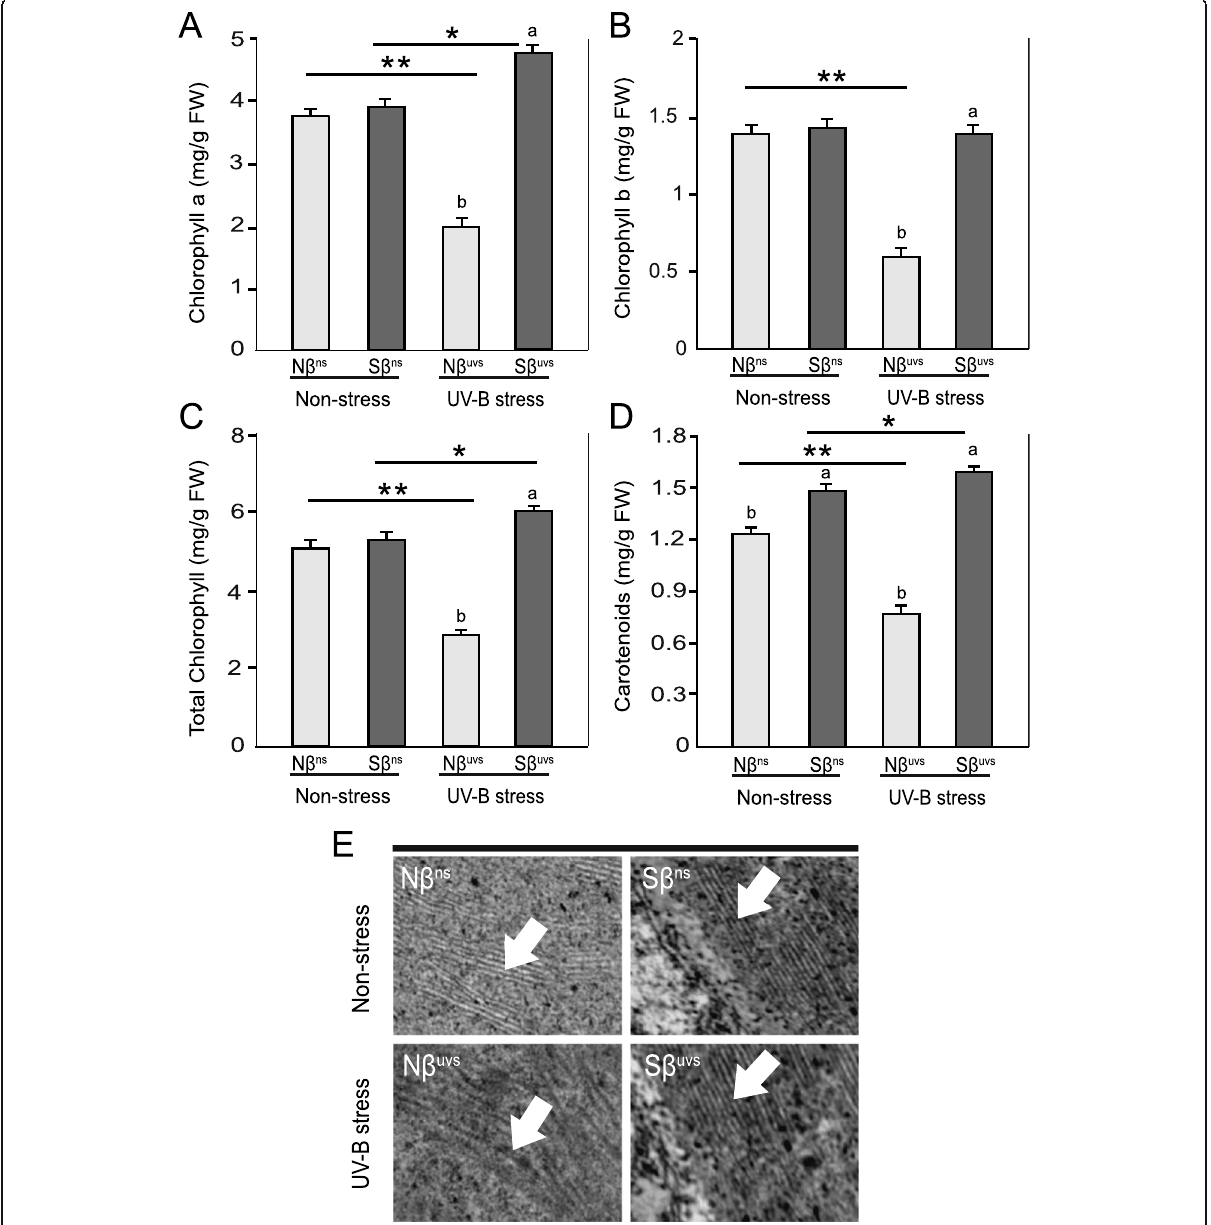
Fig. 2 Effects of prolonged UV-B stress on photosynthesis-related pigments and ultrastructure of chloroplast in N β and S β seedlings. Measurement of pigment contents: A Chlorophyll a (Chl a), B chlorophyll b (Chl b), C total chlorophyll, and D carotenoids (Caro) in N β and S β plants under non-stress and stress conditions. E Ultrastructure of the chloroplasts of N β and S β plants under non-stress and UV-B stress, showing more disintegration of grana stacks in N β under stress conditions. Data are shown as means of three independent experiments and different letters showing significant differences (P < 0.05) within the same treatment (N β ns vs. S β ns and N β uvs vs. S β uvs ). Lines with asterisks indicate significant differences between non-stress and UV-B stress conditions of the same plants (N β ns vs. N β uvs and S β ns vs. S β uvs ), as determined by Student ’ s t test (* P < 0.05, ** P <